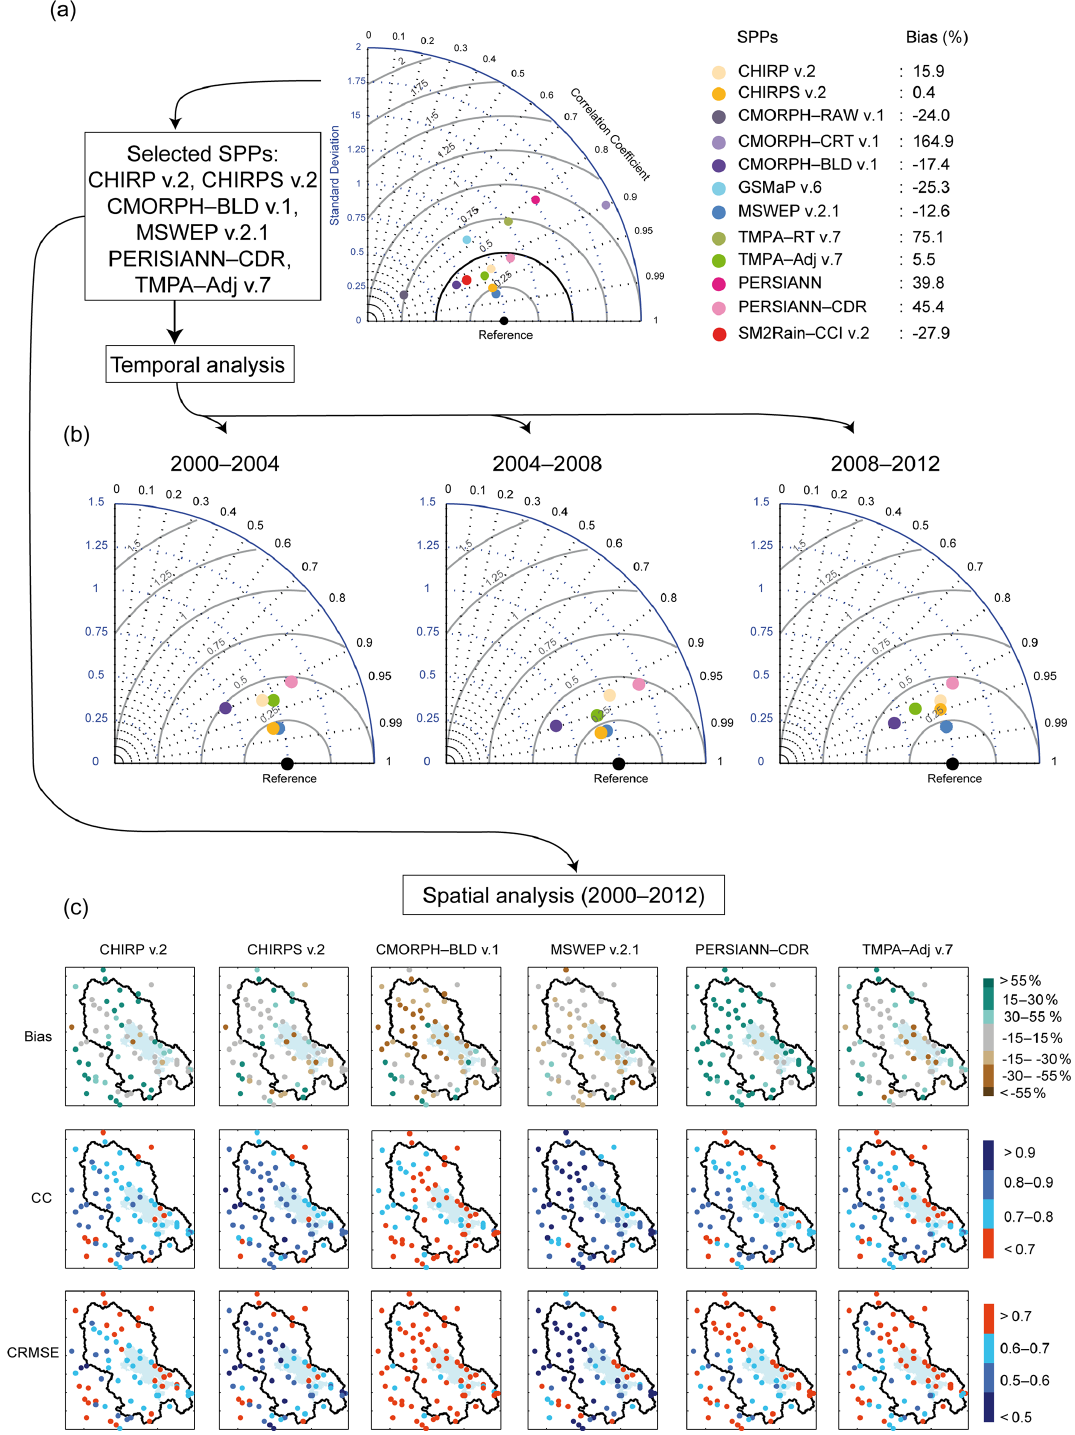
Figure 5. Efficiency of SPPs compared with gauge observations: (a) pre-selection of SPPs at the regional scale in the form of a Taylor diagram; (b) consistency of SPPs over time at the regional scale in the form of a Taylor diagram; and (c) consistency of SPPs in space for the 2000–2012 period from CC, CRMSE and % B values obtained from each P ref grid cell including at least one gauge.